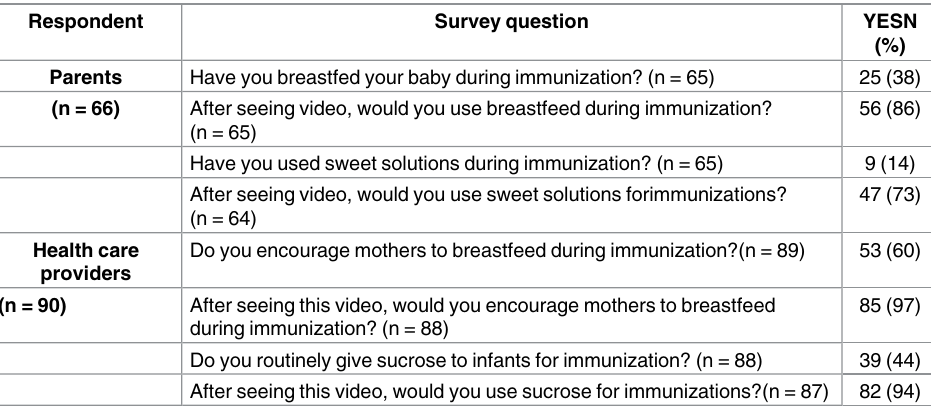
Table 2. Viewer survey